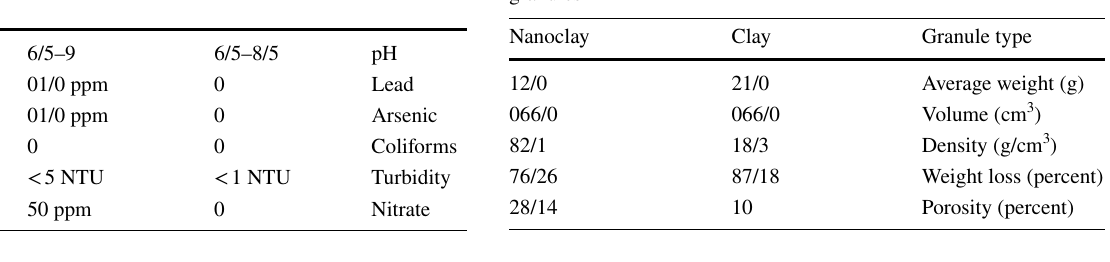
Fig. 2 Beakers containing 300 ml of sample water and granules